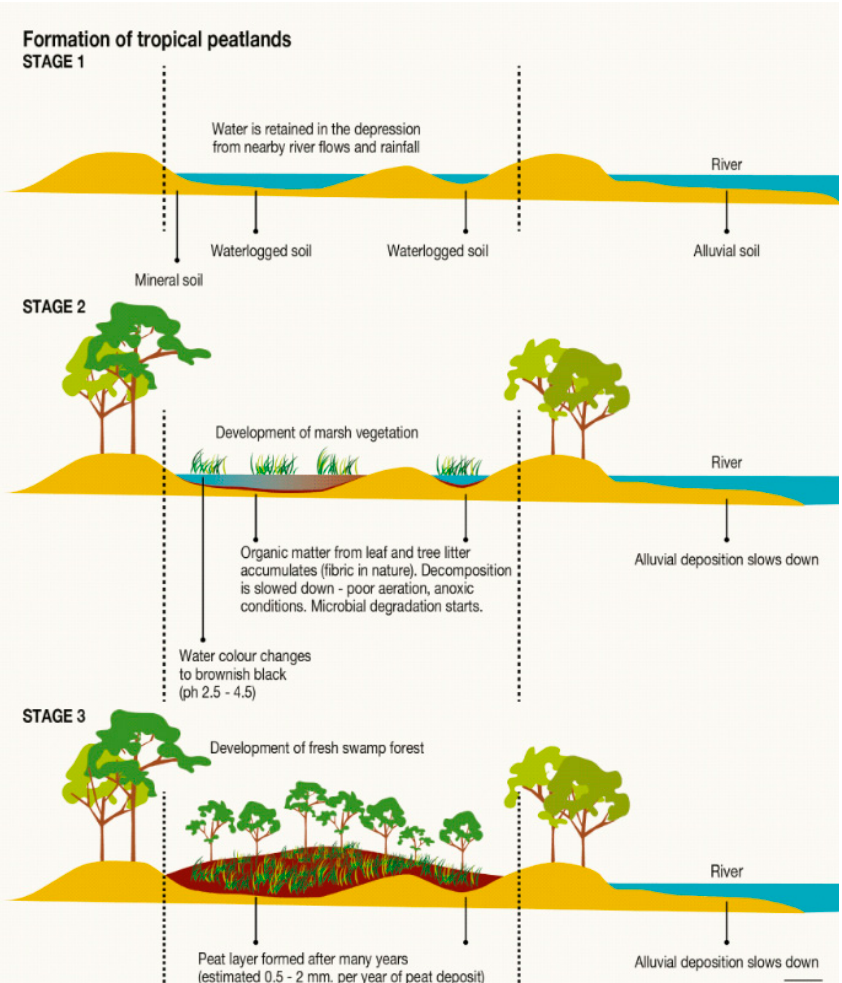
Figure 1. Schematic overview of the formation of peat domes in Indonesia and other tropical countries. Dead plant material accumulates in a water-filled depression that lacks oxygen. The accumulation rate is about 0.5–2 mm per year. After thousands of years, a convex-shaped peat dome up to a several meters thick is formed. The dome is generally covered by forests such as peat swamp forest (figure is taken from [4]).